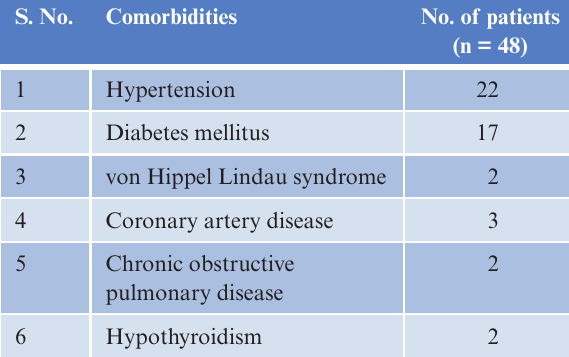
Figure 1: Presentation. Table 2: Comorbidities. S.